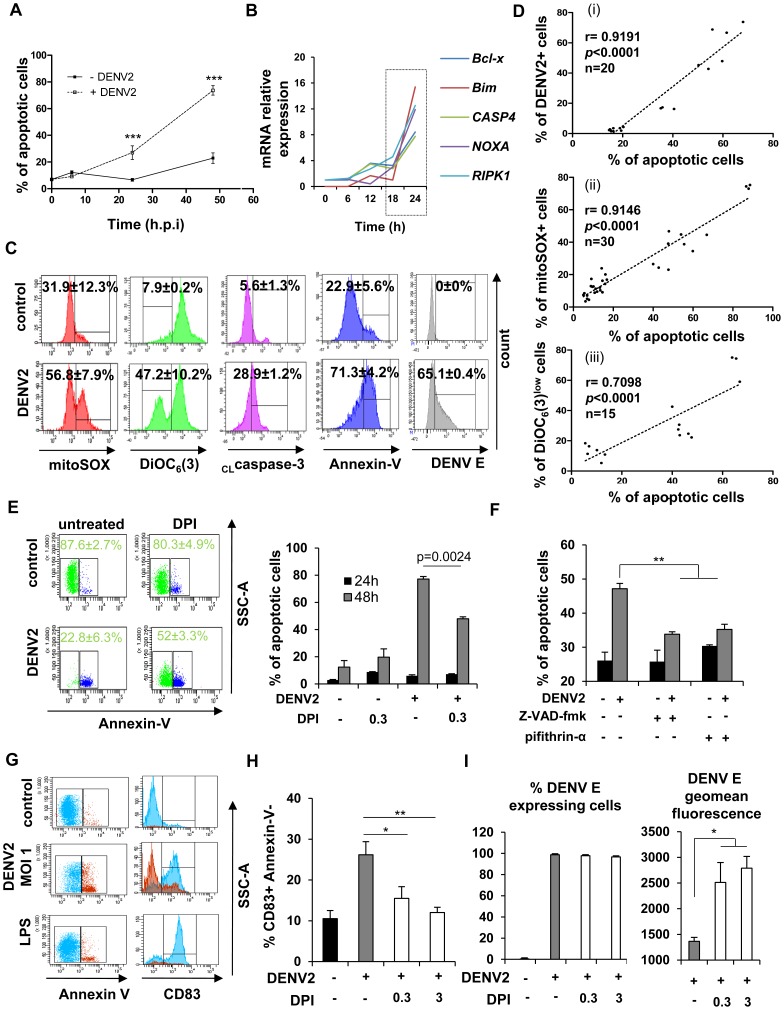
NOX-dependent ROS production triggers mitochondrial-dependent apoptosis in DENV-infected cells and activates bystander cells.(A) The percentage of apoptotic cells was assessed by Annexin-V staining at 6–48 h post-infection. Data are the means ± SEM from independent experiments performed in triplicate on five individual donors. P values were determined based on the comparison with uninfected cells at the appropriate time (B) mRNA relative expression of apoptosis-associated genes was detected by qPCR at various times post DENV2 infection. Values are representative of one donor. Experiment has been repeated on three individual donors. (C) Levels of mitoSOX red, DiOC6(3), cleaved caspase 3 (CLcaspase3), Annexin-V and DENV E protein expression were evaluated by flow cytometry 48 h post-DENV infection. Values represent the means ± SEM from at least three individual donors. (D) The correlation between (i) the percentage of DENV2+ cells at 24 h and the percentage of apoptotic cells at 48 h; (ii) the percentage of apoptotic cells and the percentage of mitoSOX+ cells at 48 h, and (iii) the percentage of apoptotic cells and the percentage of DiOC6(3)low cells at 48 h was calculated in Mo-DC using a Spearman test. (E) Percentage of apoptotic cells in DENV-infected Mo-DC was detected 48 h post-infection in the presence or absence of DPI (0.3 µM). Histograms represent the means ± SEM of three experiments performed in duplicate on three independent donors. (F) Percentage of apoptotic cells in DENV-infected Mo-DC was detected 48 h post-infection in the presence or absence of the p53 inhibitor pifithrin-α (10 µM) or the pan-caspase inhibitor Z-VAD-fmk (20 µM). Histograms represent the means ± SEM of one representative experiment performed in triplicate. P values were determined based on the comparison with DENV2-infected cells. (G) CD83 expression level was evaluated on Annexin-V+ (red) and Annexin-V− (blue) DENV-infected cell population (MOI 1) (H) Mo-DC were pre-treated with increasing concentrations of DPI (0.3–3 µM) before DENV challenge (MOI 0.5). Percent of CD83+ Annexin-V− cells was detected by flow cytometry 48 h after infection. P values were determined based on the comparison with DENV2-infected cells. Data are the means ± SEM of two experiments performed in triplicate. (I) Mo-DC pre-treated or not with increasing concentrations of DPI were cultured in the presence of DENV2 (MOI 20). After 24 h of infection, supernatants were collected and transferred for 8 h on naïve Mo-DC and cells were subsequently infected by DENV2 (MOI 20). DENV infection was assessed 24 h later by flow cytometry. The values are means ± SEM from one experiment performed in triplicate. P values were determined based on the comparison with DENV2 infected cells.